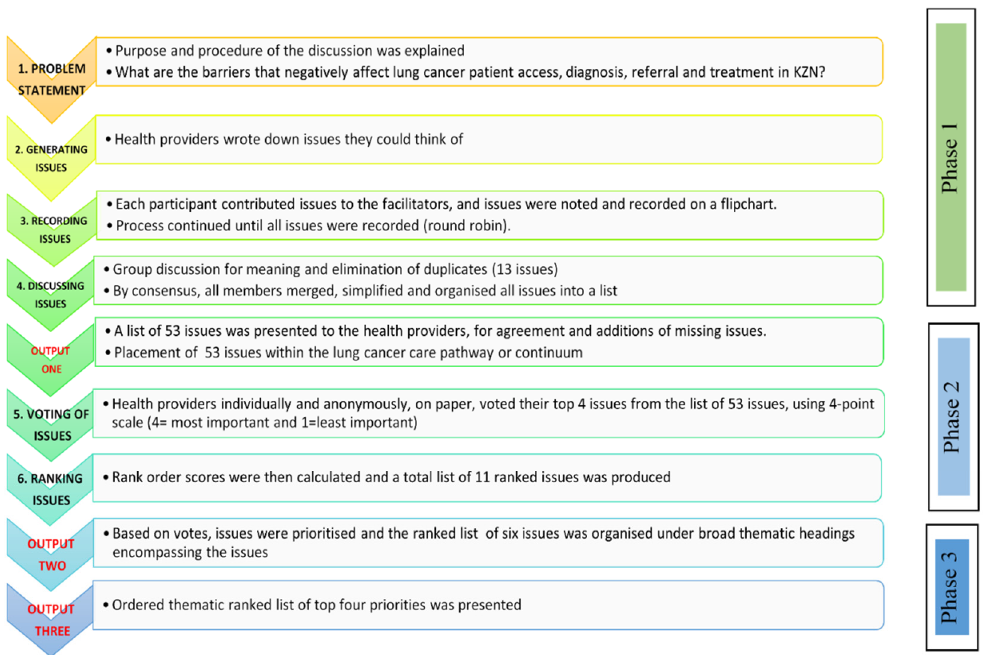
Figure 2. Nominal Group Process Flow followed in this study. Source: Developed from this